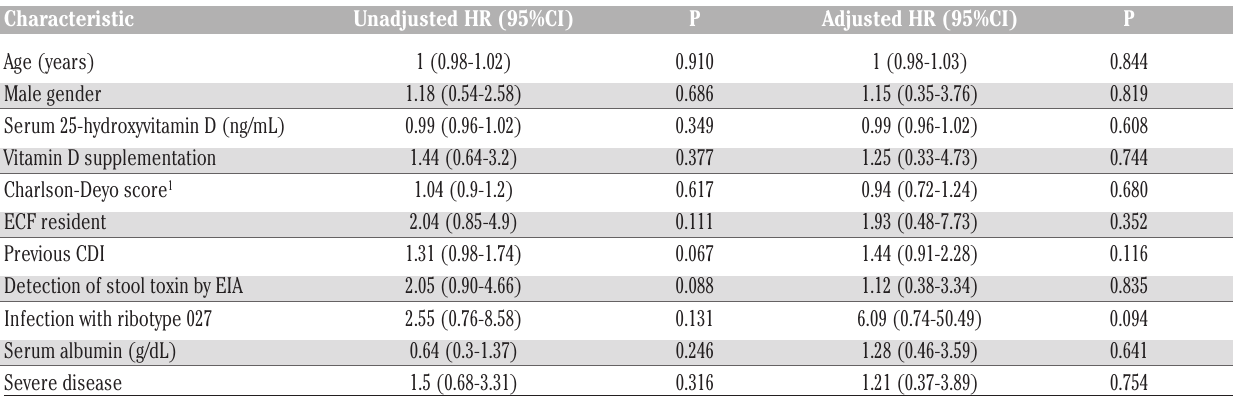
Table 3. Unadjusted and adjusted Cox proportional-hazards analysis for independent predictors of recurrent disease.